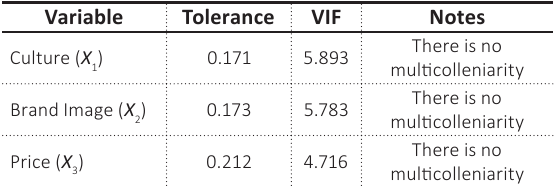
Table 2. Multi-collinearity test result